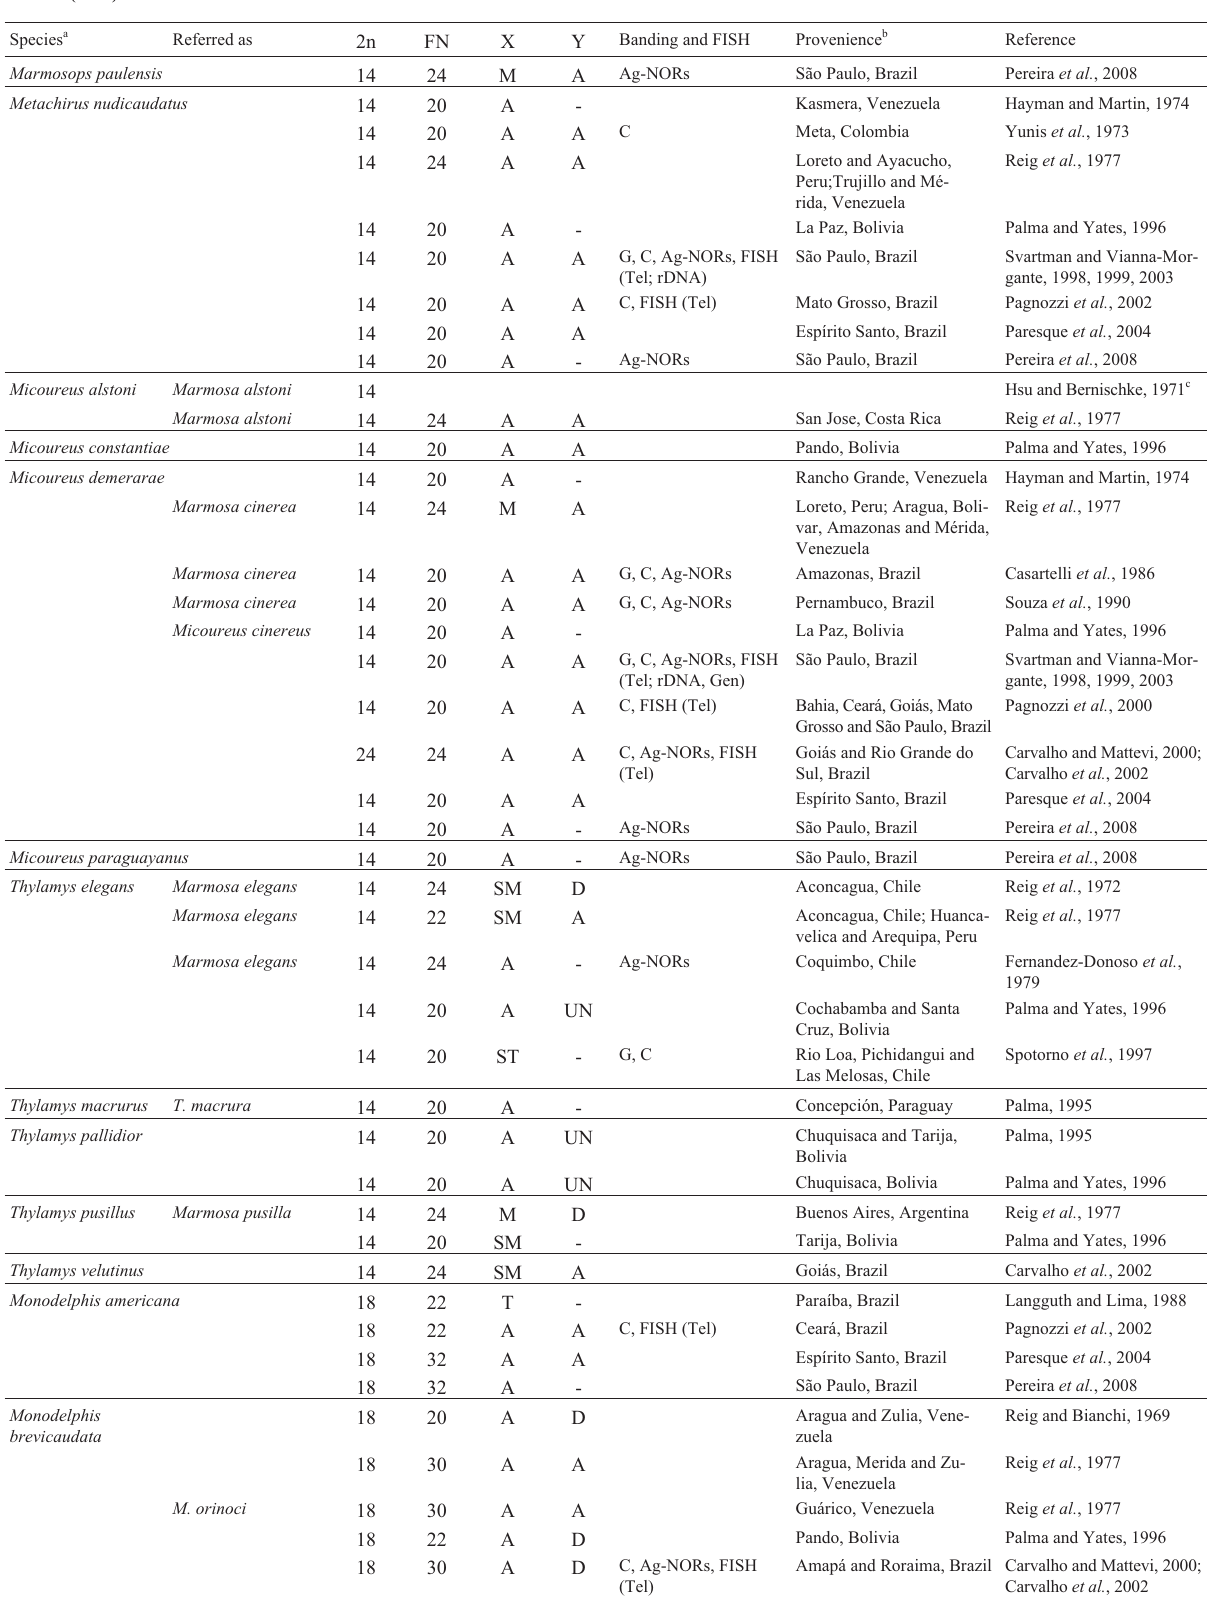
Table 1 (cont.) Species